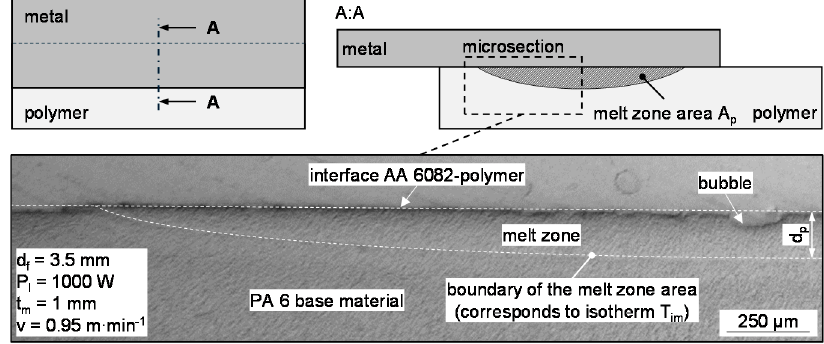
Figure 4. Cross-section of the molten zone in the polymer (metal removed in cross-section). Further variables were also considered in the development of new dimensionless